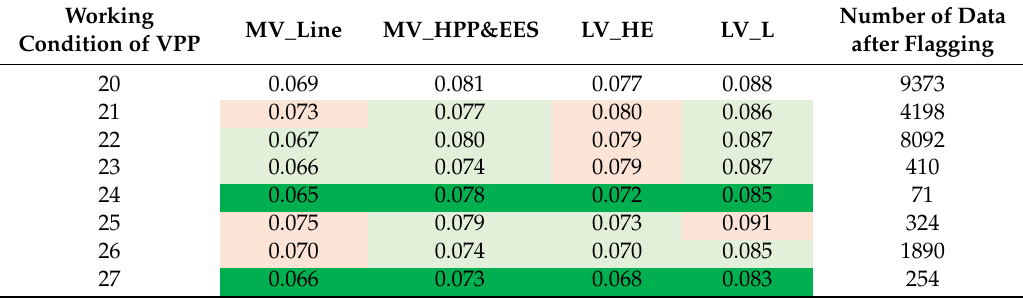
Table 9. Impact of flagging concept for area-related approach.